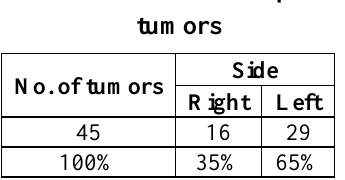
Table 2: Distribution of parotid